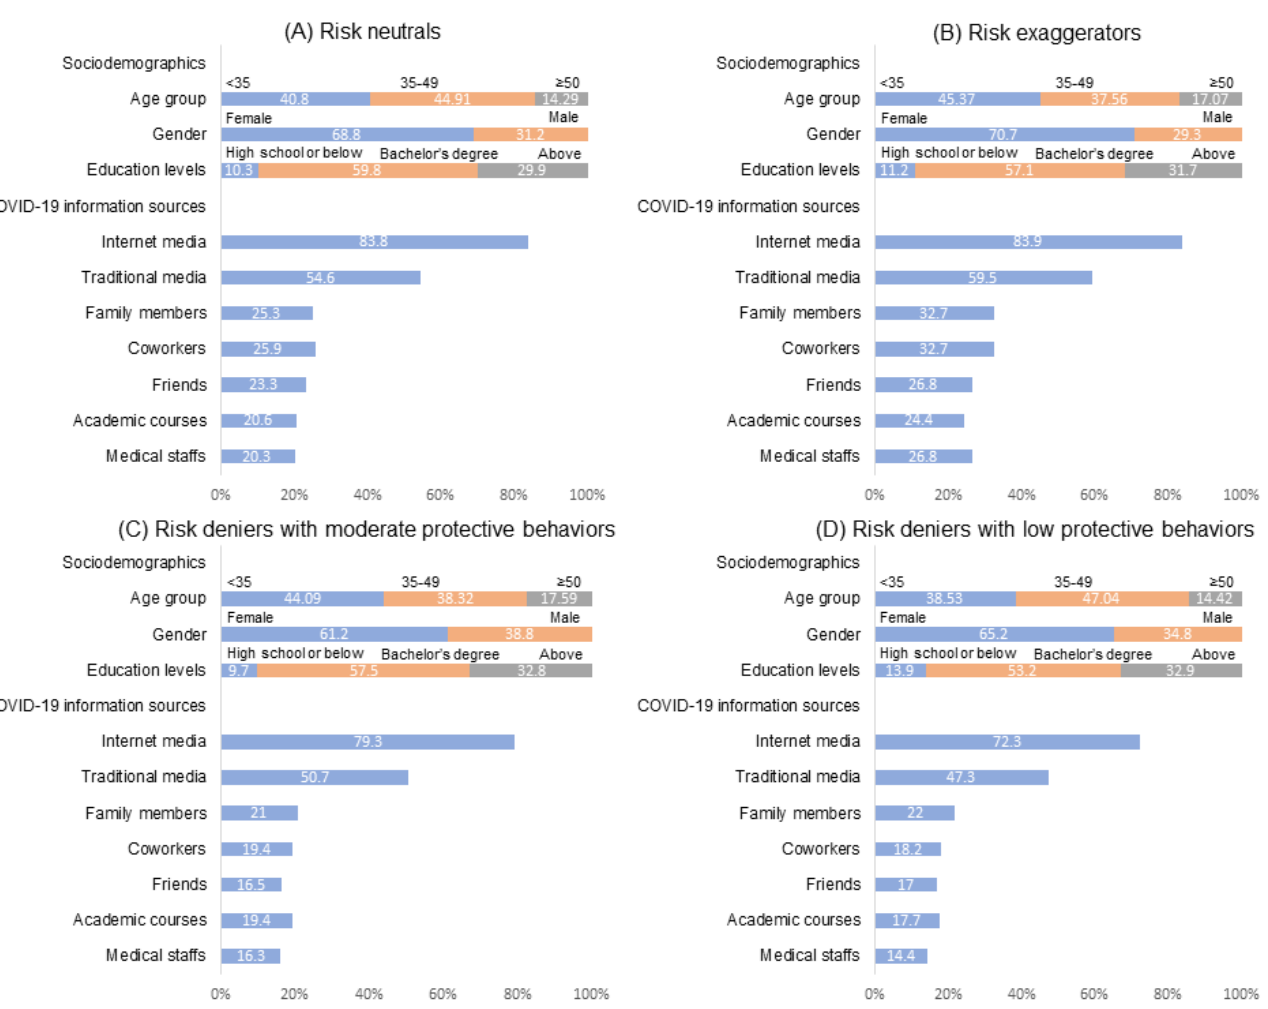
Figure 2. Sociodemographics and COVID-19 information sources between four classes of participants.